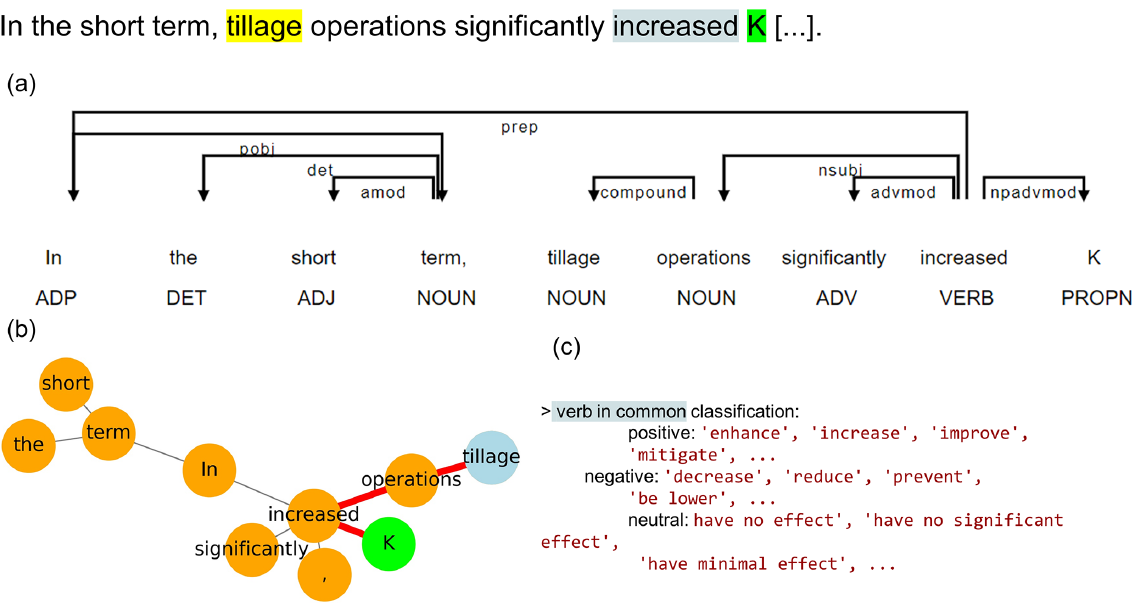
Figure 3. Example of NLP extraction on a sentence. Panel (a) shows the part-of-speech (POS) tag below each token and the dependencies (arrows) to other tokens. (b) Based on these dependencies, a network graph was created, and the shortest dependency path between the driver (blue circle) and the variable (green circle) is shown in red. (c) The verb contained in the shortest dependency path was classified into positive, negative or neutral according to pre-established lists.